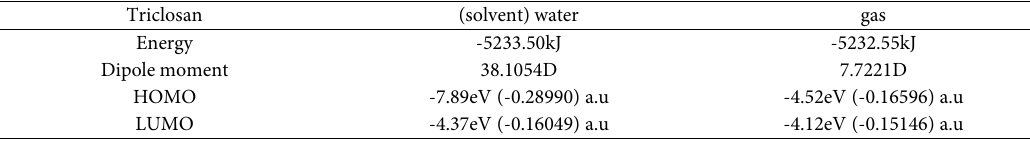
Table 1. Energy data and dipole momentum of triclosan by B3LYP/6-311++G(2d,2p)